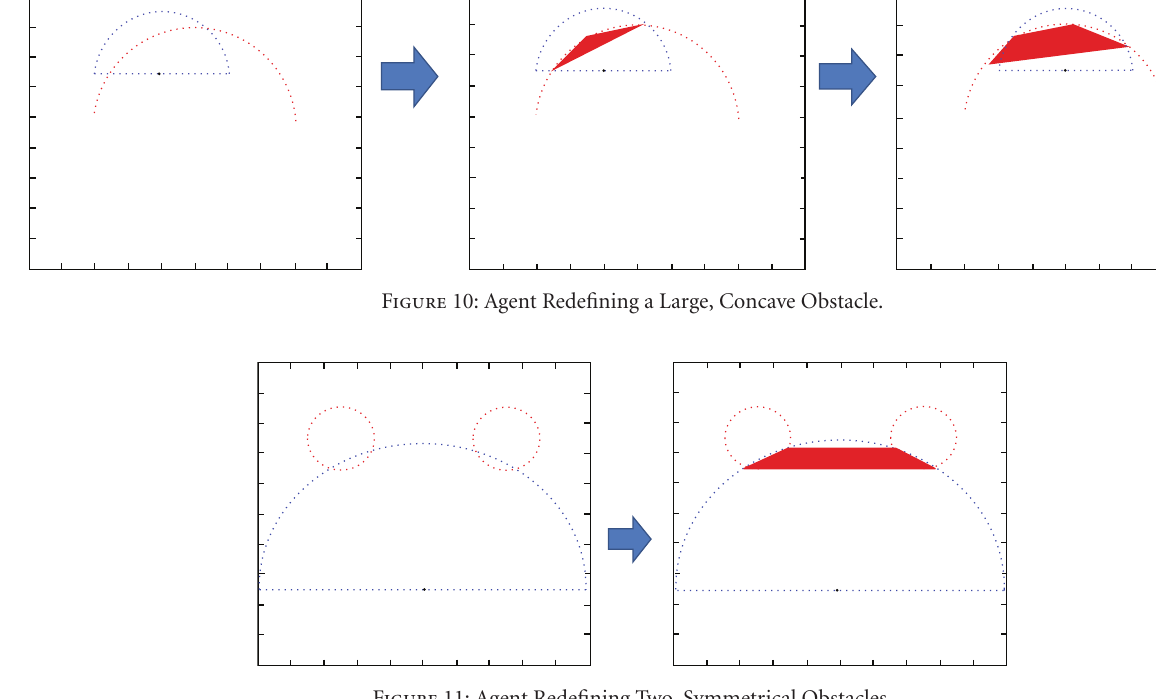
Figure 11: Agent Redefining Two, Symmetrical